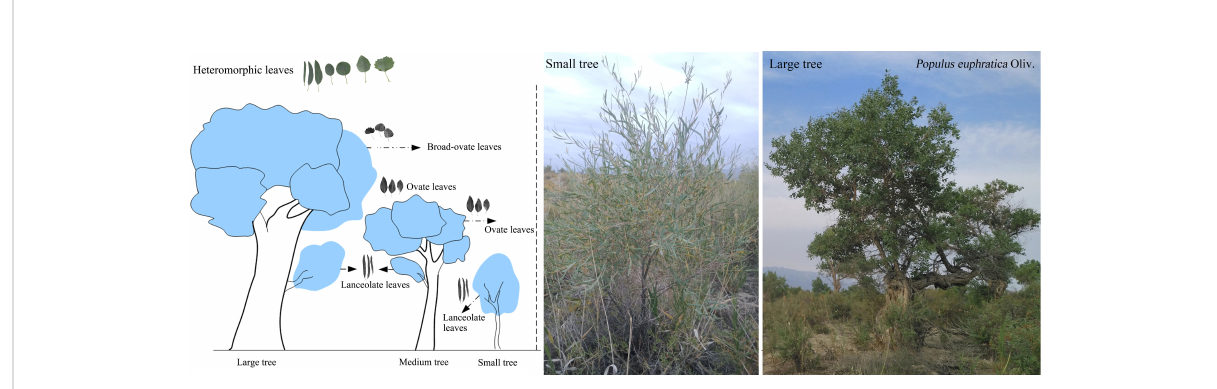
FIGURE 1 Spatial distribution of the three types of heteromorphic